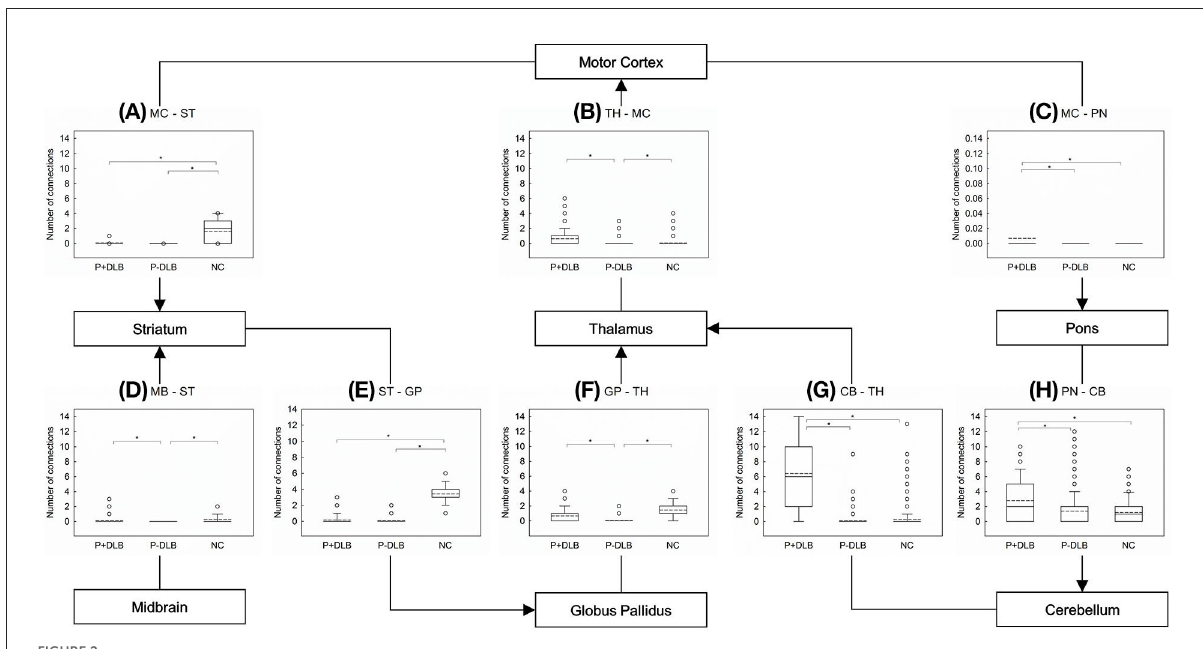
FIGURE2 Comparison of the number of inter-regional connections among P + DLB, P-DLB, and NC groups. Box plots of the mean number of connections between (A) MC–ST; (B) TH-MC, (C) MC-PN, (D) MB-ST, (E) ST-GP, (F) GP-TH, (G) CB-TH, and (H) PN-CB. The solid lines represent the median value and dashed lines represent the mean value. * indicate significantly different group means at p < 0.001. P + DLB, dementia with Lewy bodies with parkinsonism; P-DLB, dementia with Lewy bodies without parkinsonism; NC, normal controls; MC, motor cortex; ST, striatum; PN, pons;